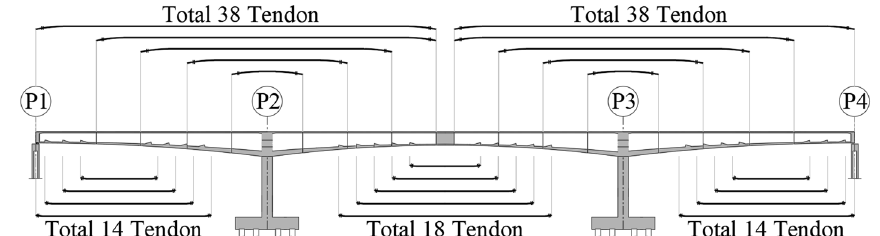
Fig. 19 Longitudinal prestressing layout of Talkha